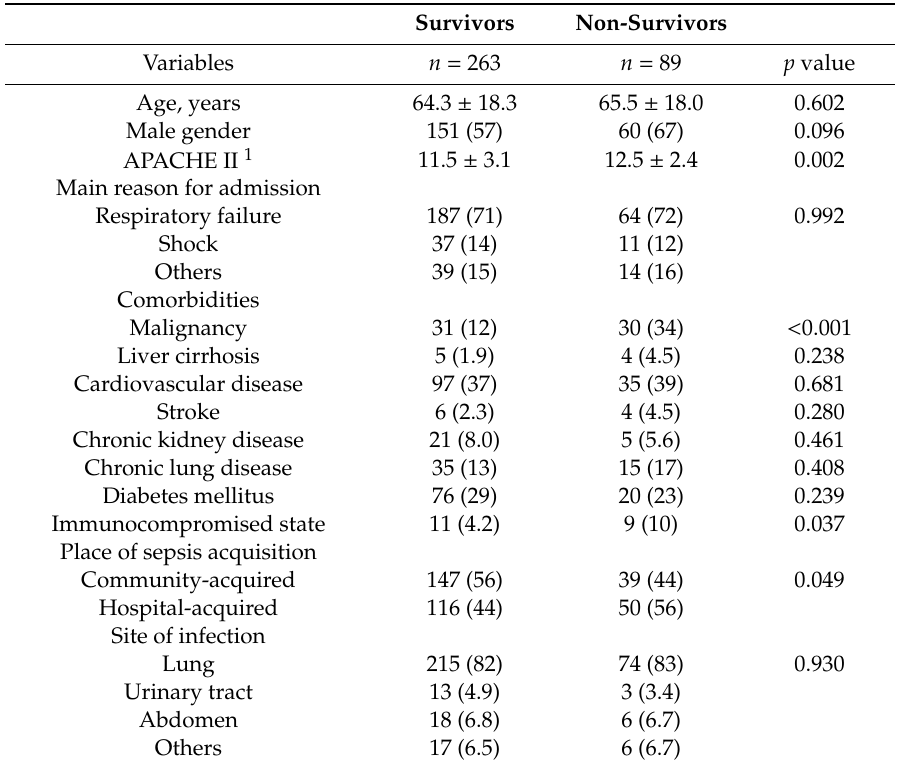
Table 1. Characteristics of the study population.